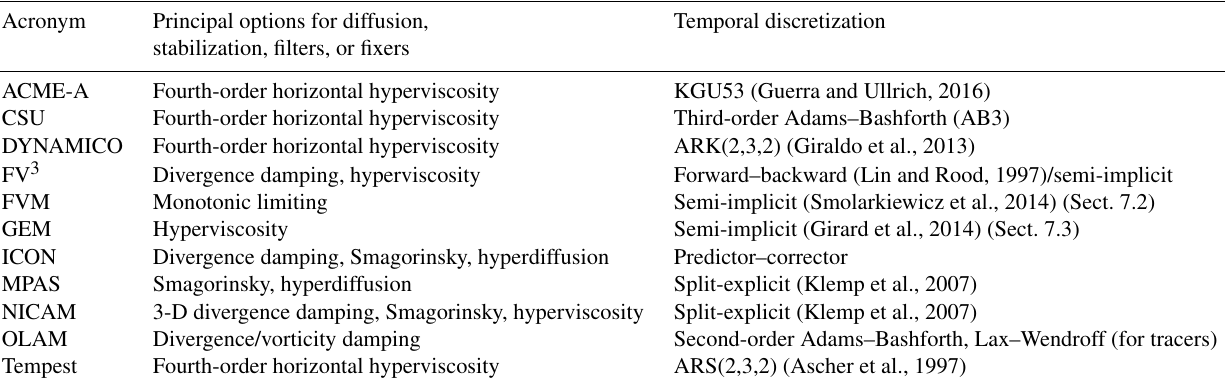
Table 5. Principal options for diffusion, stabilization, filters, or fixers in participating dynamical cores (detailed in Sect. 6) and temporal discretization (detailed in Sect.